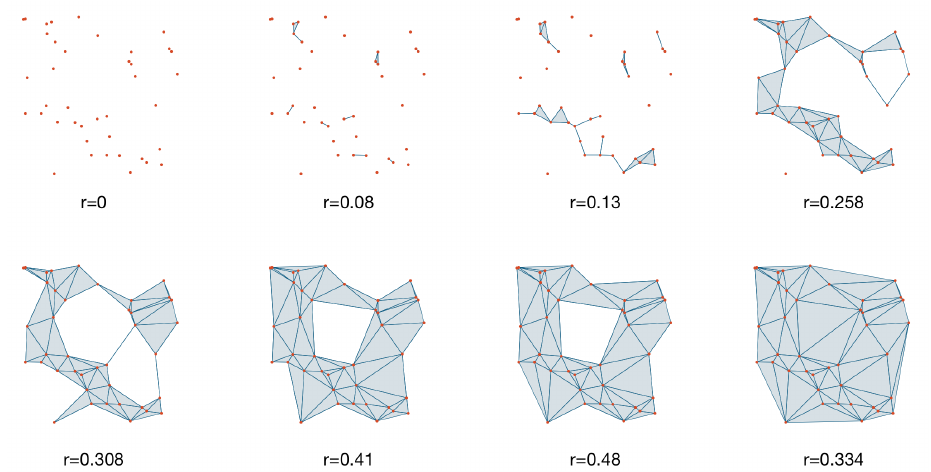
Figure 3. Persistent